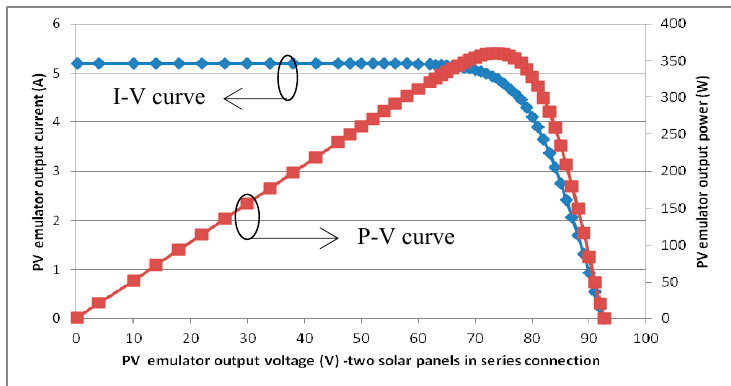
Figure 20. Measured I-V and P-V characteristics of the constructed PV source with two PV panels connected in series.